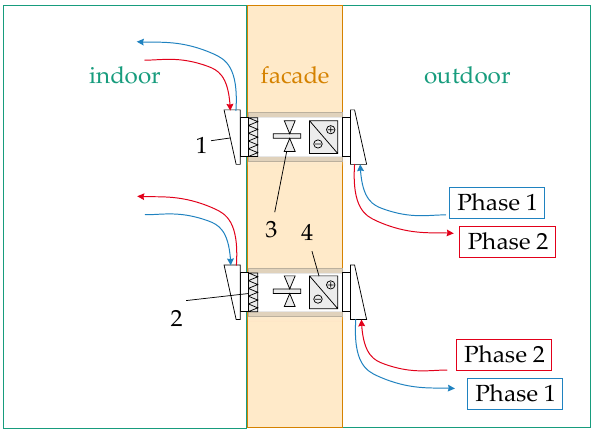
Figure 2. Sketch of a pair of push-pull ventilation devices; (1) aperture, (2) filter, (3) axial fan, (4) regenerative heat exchanger.